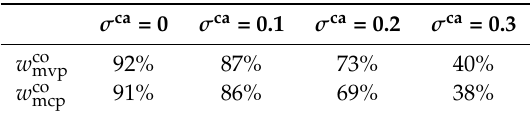
Table 2. Composition of minimum variance portfolios (mvp) and minimum CVaRD portfolios (mcp) for the fully dispatchable